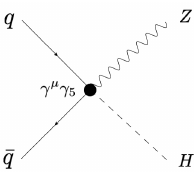
Figure 3: The amendment vertex to the Lagrangian for using NAC in